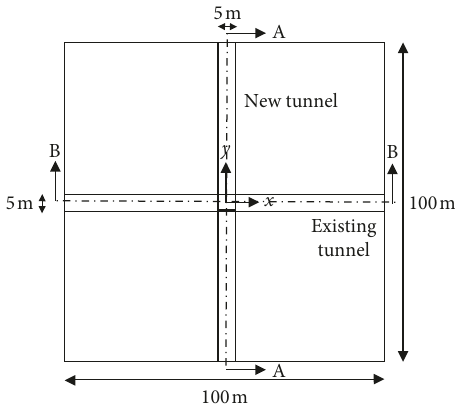
Figure 1: Plan view of S1 and